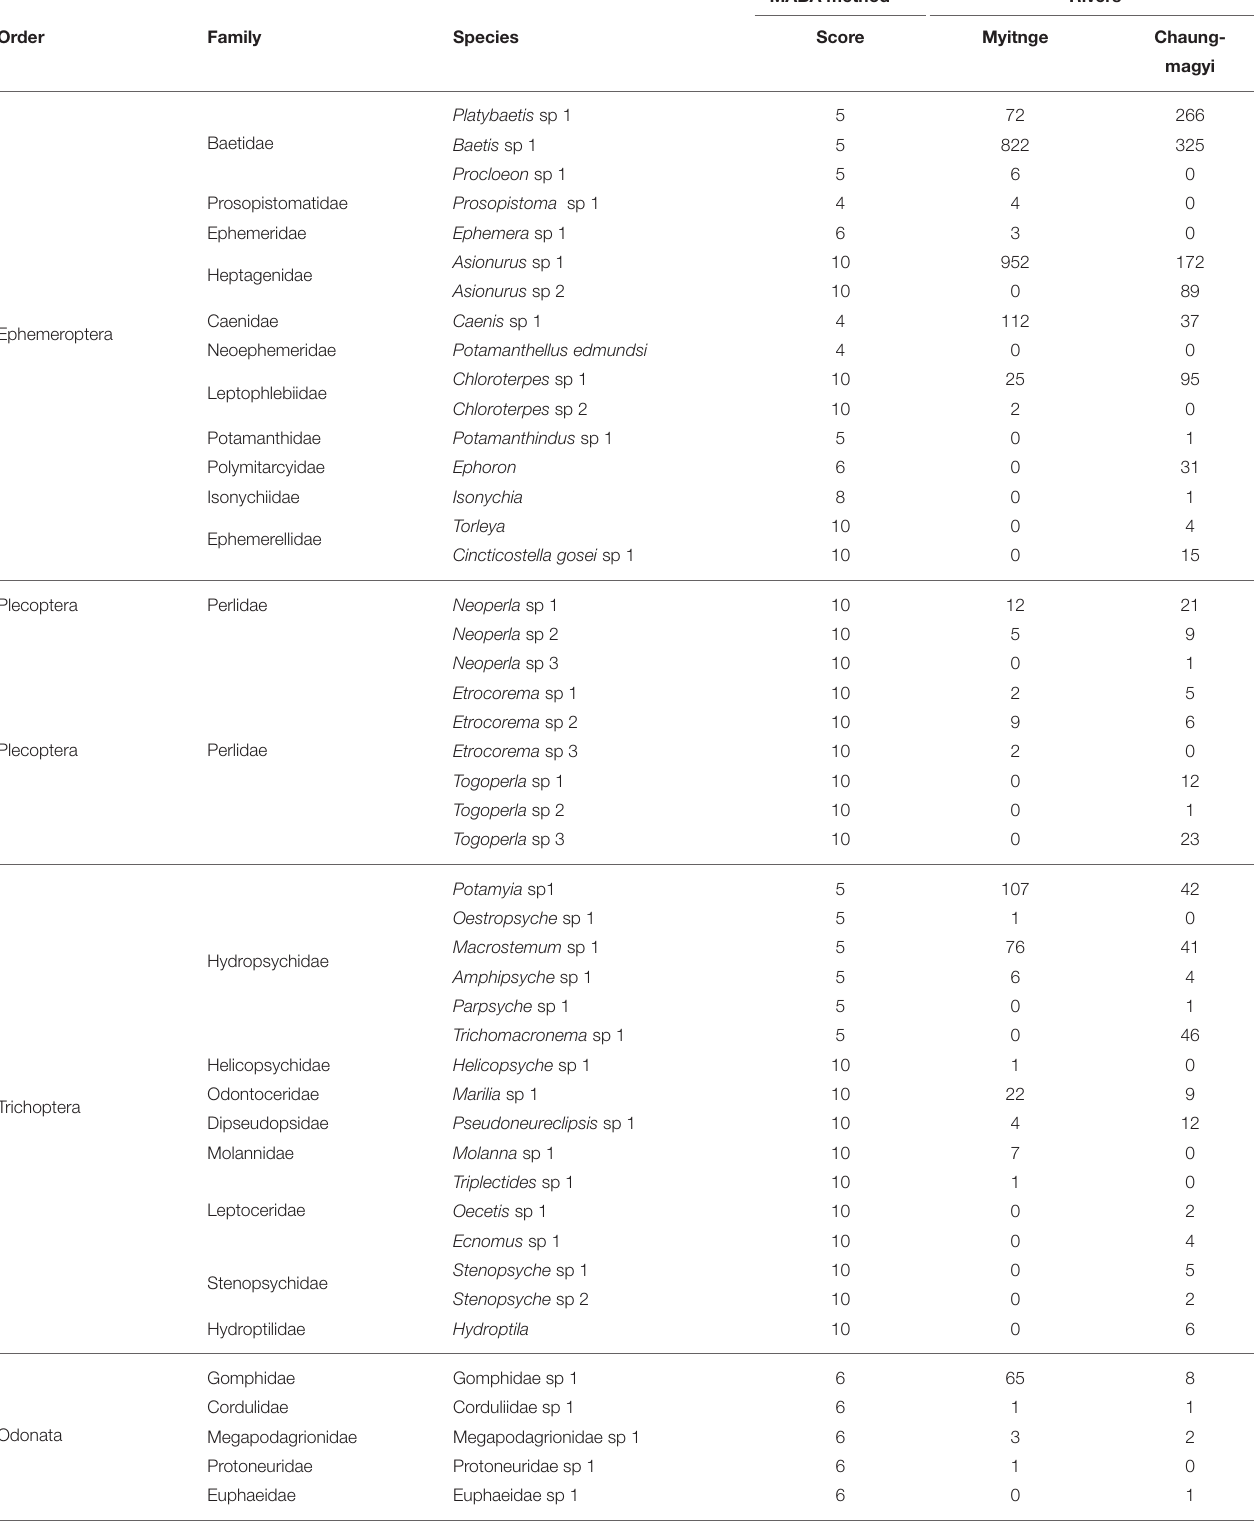
TABLE 3 | Collected total abundance and their score of The Myanmar Aquatic Biomonitoring Assessment Index (MABA) by Ko et al.